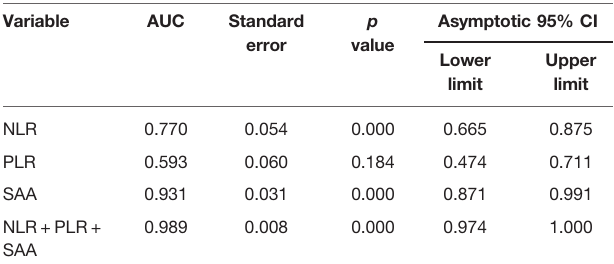
TABLE 2 | Value of serum NLR, PLR and SAA levels in predicting patients with stage I – II CRC.